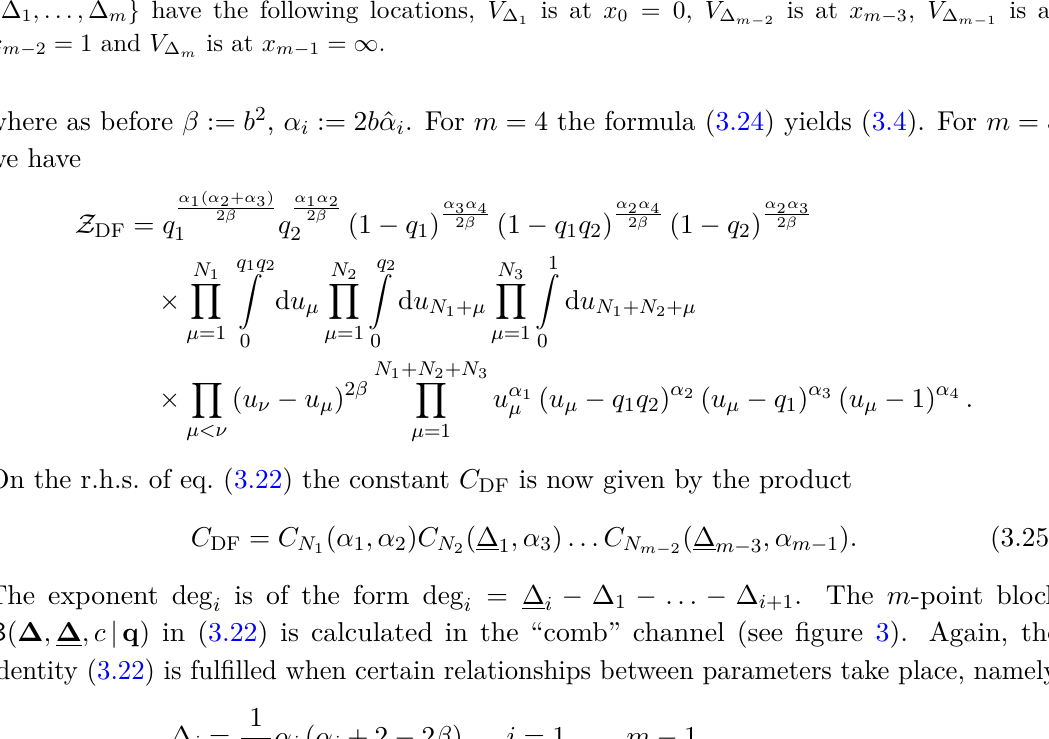
is at x = 0 , V is at x , V is at 0 m − 3 ∆ m − 2 ∆ m − 1 1